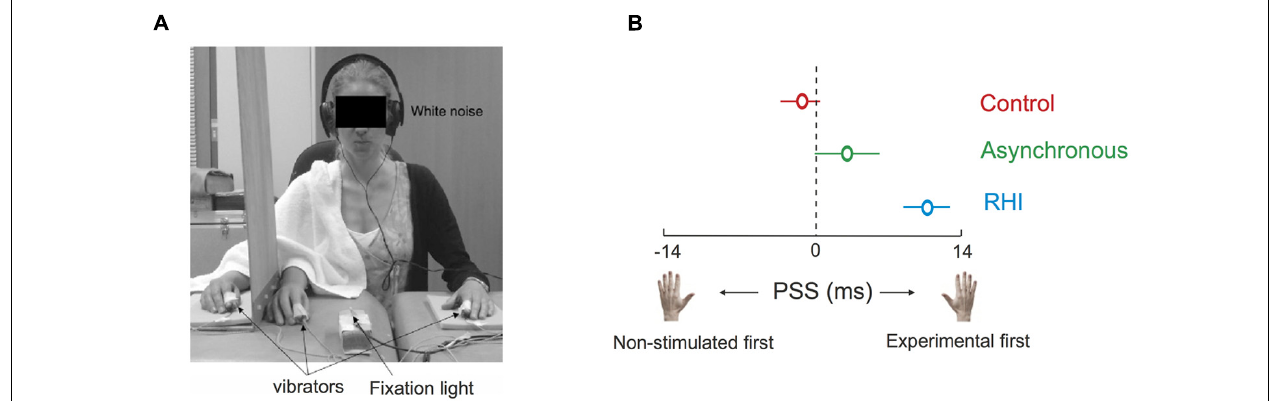
control trials (no stroking), asynchronous stroking of the rubber and the experimental hand, and during the RHI. (B) During the RHI, the tactile stimulus had to be presented to the experimental hand before the tactile stimulus was presented to the non-stimulated hand in order for them to be perceived as occurring at the same time, as compared to the asynchronous and control conditions. Figure modified from Moseley etal. (2008), Copyright (2008) National Academy of Sciences,